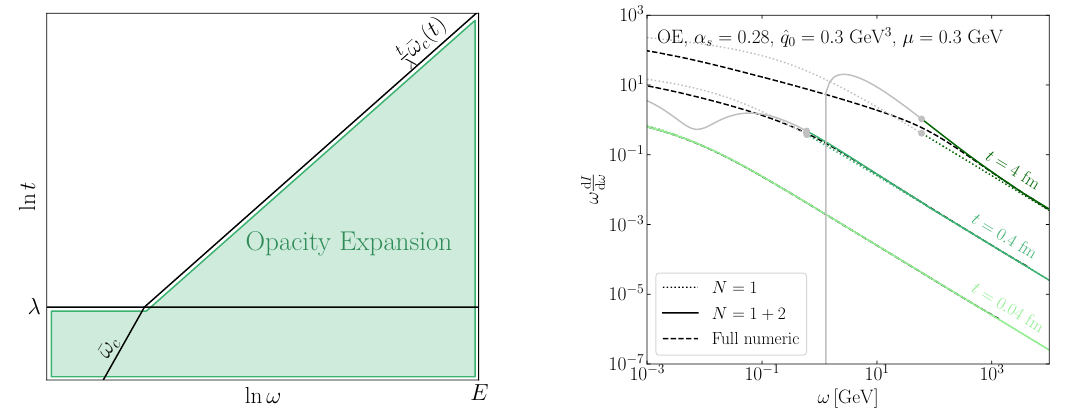
Figure 4 . Left: the sketch of the region of validity (and convergence) of the opacity expansion for different propagation length t and emission energy ω . Right: the induced emission spectrum for gluons in the opacity expansion. The gray part of the curves denotes regions, where the expansion is not valid. Using the parameters presented, λ = 0 . 06 fm. The full numeric solution is also presented with dashed